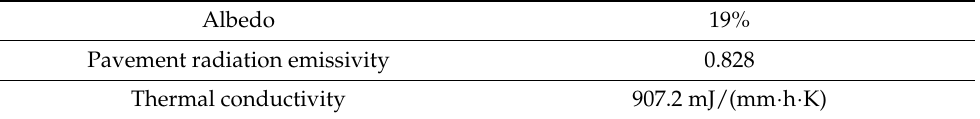
Table 1. Thermal properties of the cool pavement on a global